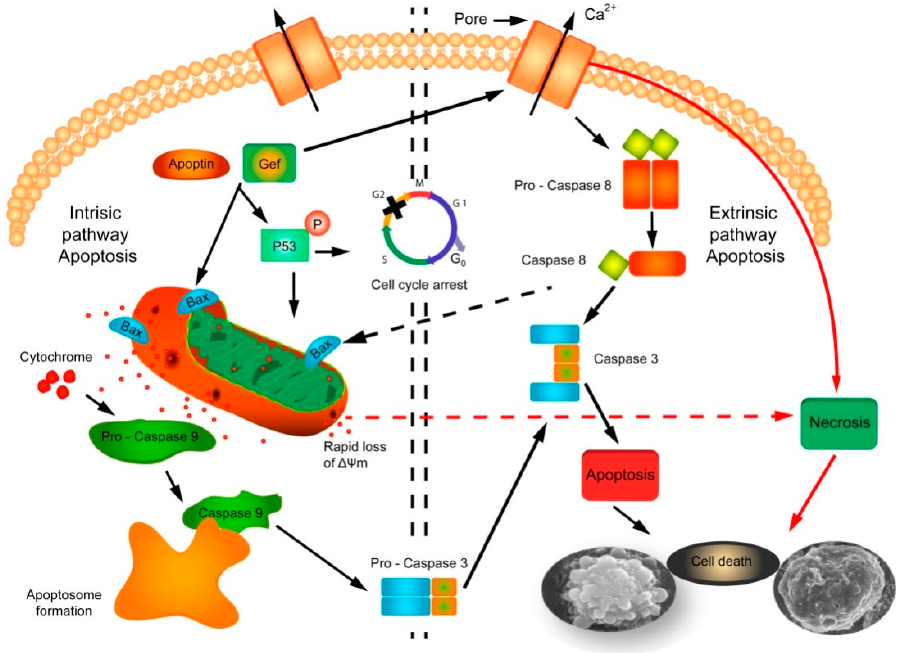
Figure 6. Schematic representation of cell death pathways induced by gef/apoptin. gef/apoptin expression induces a decrease in DLD-1 cell growth and viability by triggering necrosis and apoptosis through both the intrinsic and extrinsic apoptotic pathways. Cellular stress induces apoptosis intrinsic pathway and activates the Bcl-2 family of proteins. Pore formation is then promoted by BAX oligomers in the outer mitochondrial membrane and releases various proteins including cytochrome c. Procaspase-9 is recruited by the apoptosome through cytochrome c induction, inducing the dimerization and activation of caspase-9. Caspase-9 activation triggers caspase cascade and finally induces executioner caspases-3. These caspases are responsible for cleavage of numerous cellular proteins, leading to apoptosis. In the extrinsic caspase-8 dependent pathway there are two different ways. The type I pathway, where caspase-8 directly cleaves and activates caspase-3 leading to cell death, and the type II pathway, wherecaspase-8 activates BAX leading to mitochondrial pore formation and the activation of the caspase cascade culminating in caspase-3 activation.